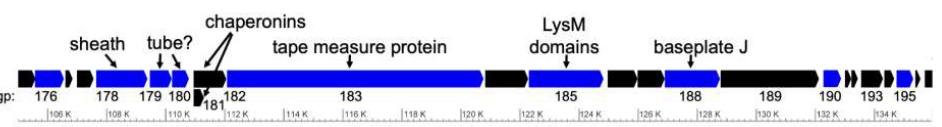
Figure 10. The phage G genome region containing the major tail morphogenesis genes. Gene products (gp), identified by mass spectrometry [4] in purified virions, are shaded blue.